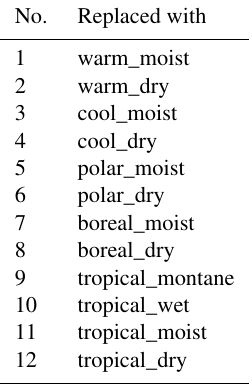
Table C2. Climatic zone number